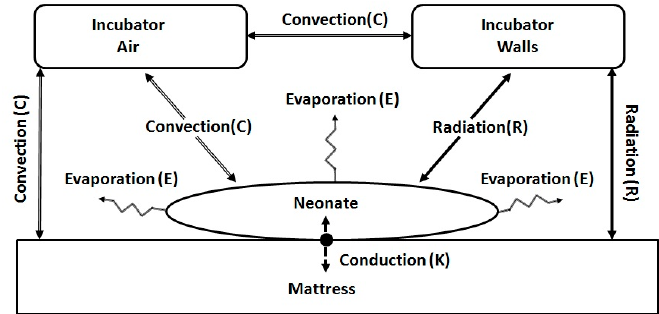
Figure 1. A simplified block diagram of the heat exchanges between the neonate’s skin and the environment: K, C, R and E are respectively the conductive, convective, radiant and evaporative heat transfers.